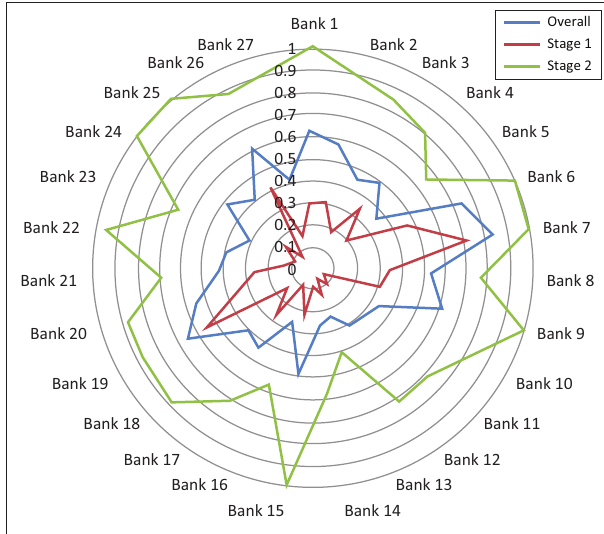
FIGURE 3: Mean slack-based of the overall, Stage 1 and Stage 2 of banks in